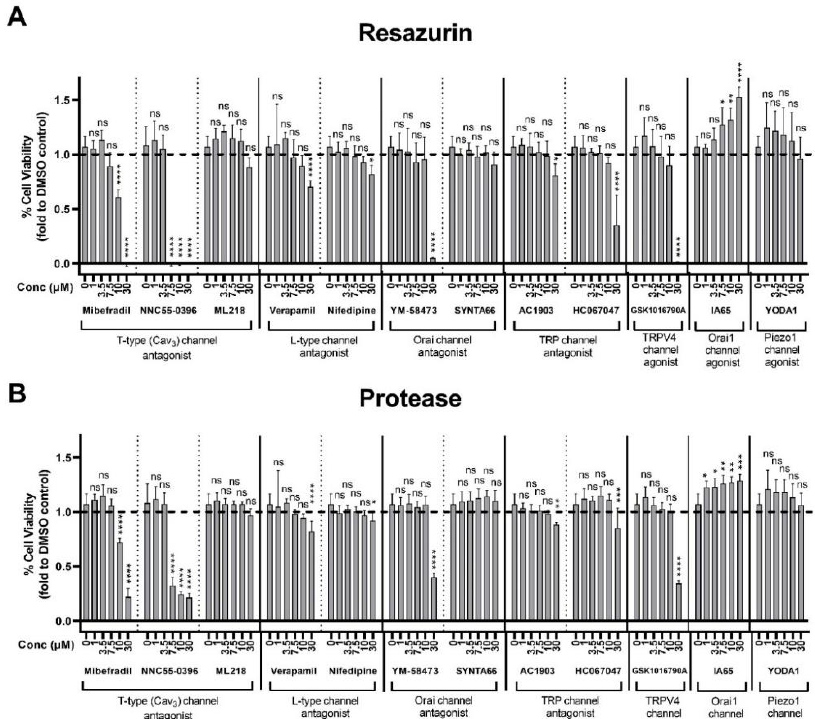
Figure 6. Effect of plasma membrane calcium channel modulators on substrate-independent growth of MB cells. D341 cells (10,000 cells/well in agar) were treated with DMSO (solvent control) or different concentrations of test compounds from 1 to 30 µM. After 7 days, plates were analysed by quantifying ( A ) resazurin and ( B ) GF-AFC substrate fluorescence. Data represent mean ± standard deviation from two independent assays with four replicates each. The control group for both assays is the same and 0.3% DMSO was used as solvent control for all the compounds except for NNC55-0396, where media was used. ns = not significant ( p > 0.05), * p < 0.05, ** p < 0.01, *** p < 0.001, **** p < 0.001 (one-way